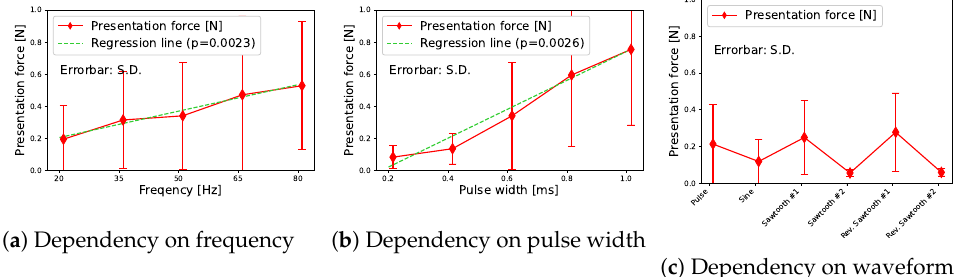
Figure 4. Presentation forces; ( a ) for each frequency; ( b ) for each pulse width; and ( c ) for each waveform. In ( c ), the outliers are